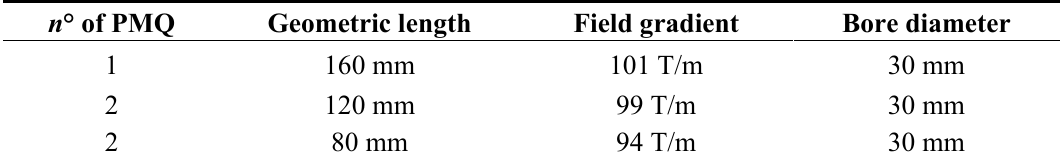
Table 1. The ELIMED PMQs system features.